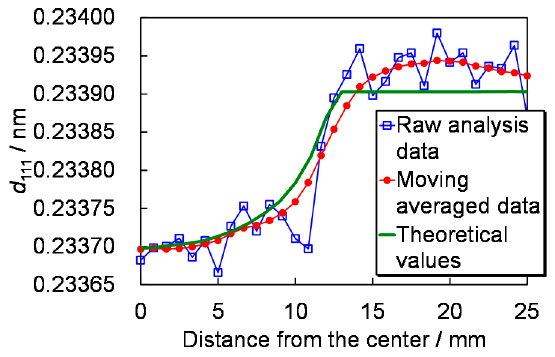
Figure 17. Radial dependence of the projection data evaluated by RITS, its moving averaged (smoothed) data which were actually used for the CT image reconstruction and the theoretical values of projection data from the VAMAS cylinder [54].